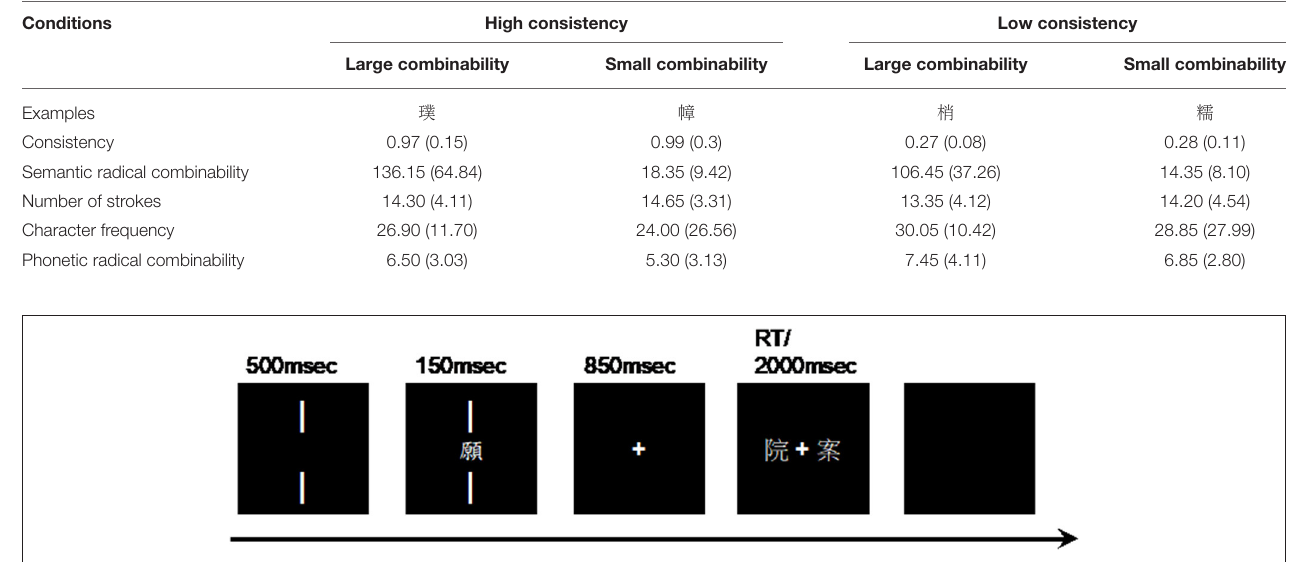
TABLE 1 | Means and SDs (in parentheses) of parameters for stimuli in the experiment.